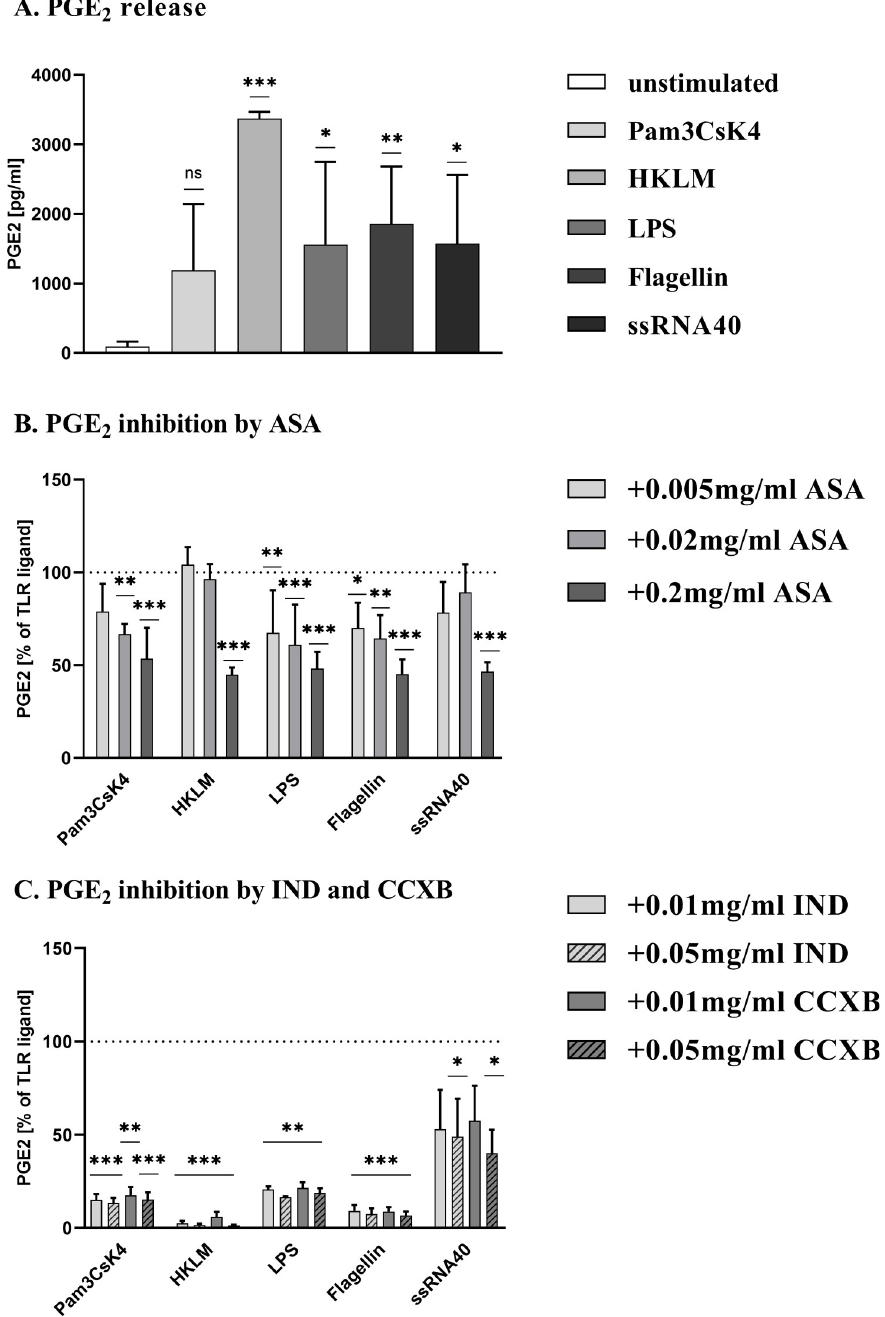
Fig 5. ASA, IND and CCXB inhibit TLR ligand-stimulated PGE 2 production in WB. Citrate-anticoagulated blood was incubated with (A) Pam3CsK4, HKLM, LPS, Flagellin or ssRNA40 and PGE 2 production was measured. Results are expressed as mean ± SD of four experiments performed in triplicate. Differences were significant at p < 0.05 ( � ), p < 0.01 ( �� ) or p < 0.001 ( ��� ) as indicated, compared to unstimulated WB. (B) Various concentrations of ASA or vehicle following stimulation with TLR agonists. PGE 2 production is expressed in percent compared to TLR agonist alone (vehicle), which is defined as 100%. Data represent mean ± SD of four experiments performed in triplicate. (C) Various concentrations of IND, CCXB or vehicle following stimulation with TLR agonists. PGE 2 production is expressed in percent compared to TLR agonist alone (vehicle), which is defined as 100%. Data represent mean ± SD of four experiments performed in duplicate. Differences were significant at p < 0.05 ( � ), p < 0.01 ( �� ) or p < 0.001 ( ��� ) as indicated, compared to WB incubated without ASA, IND or CCXB.